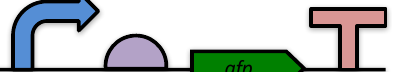
Figure 27: DNA sequence for a functional unit in which the pTet promoter and an anonymous ribosome entry site regulate expression of a coding sequence for GFP, ended by a terminator.